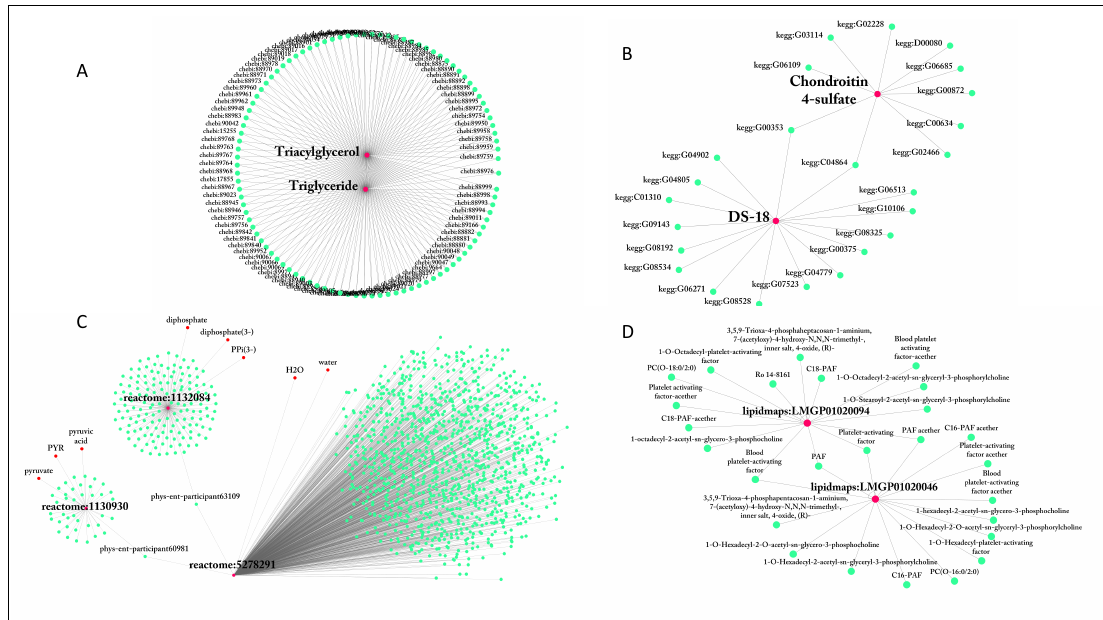
Figure 2. Intra database consistency. Edges indicate a link between a metabolite name and a database ID.